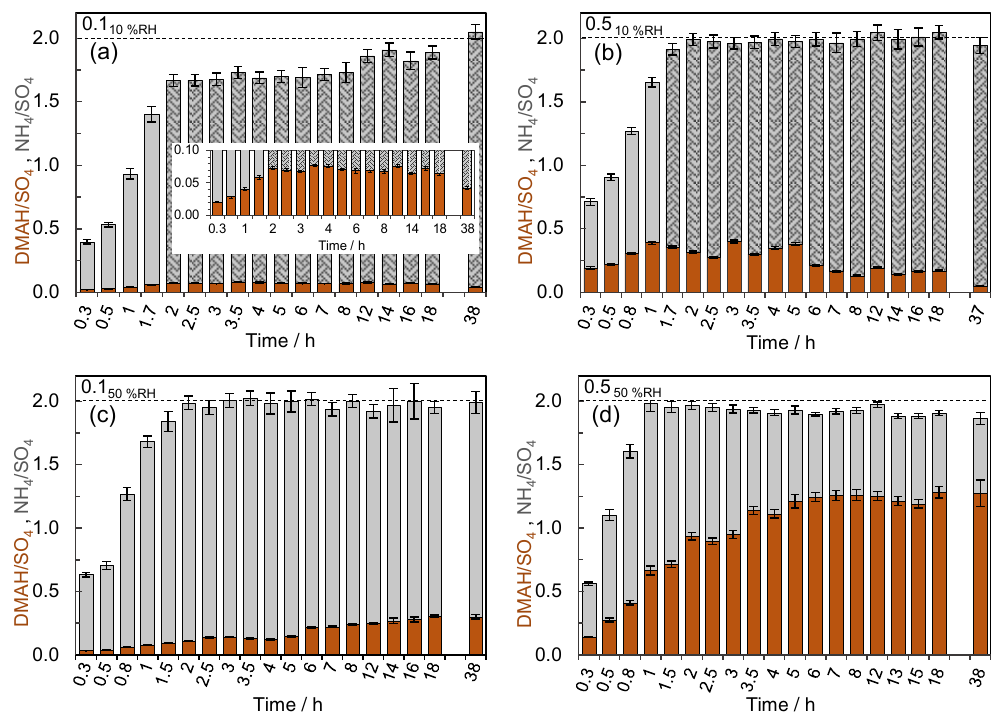
Figure 2. Co-uptake of DMA and NH 3 into H 2 SO 4 as a function of time: (a) DMA / NH 3 = 0 . 07 at 10% RH (0.1 10% ), (b) DMA / NH 3 = 0 . 46 at 10% RH (0.5 10% ), (c) DMA / NH 3 = 0 . 07 at 50% RH (0.1 50% ) and (d) DMA / NH 3 = 0 . 49 at 50% RH (0.5 50% ). A value of two indicates complete neutralisation of H 2 SO 4 . Contributions of DMAH (brown) and NH 4 (grey) to the neutralisation are shown as molar ratios (DMAH / SO 4 and NH 4 / SO 4 ). Crosshatched NH 4 bars indicate that the majority of particles underwent phase transition from liquid to solid. The inner graph in (a) is a magnified view of the DMAH